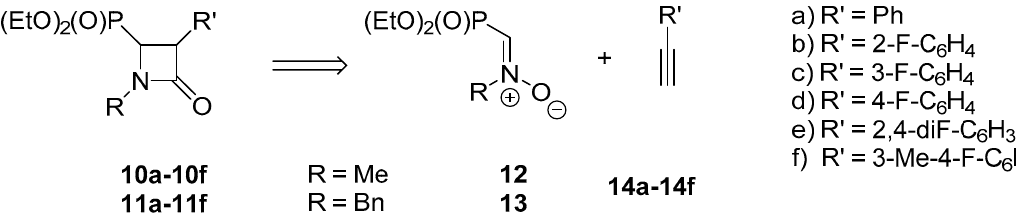
Table 1. Cycloaddtion of nitrone 12 with arylalkynes 14 .